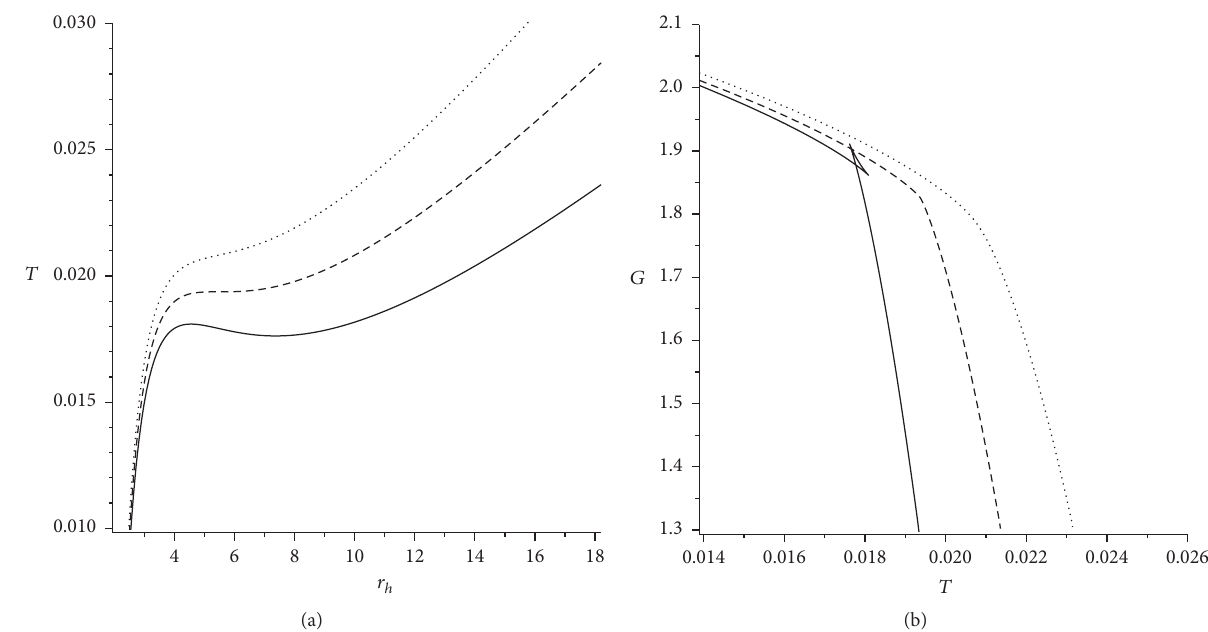
𝐺 - 𝑇 plot. On both (a) and (b), from